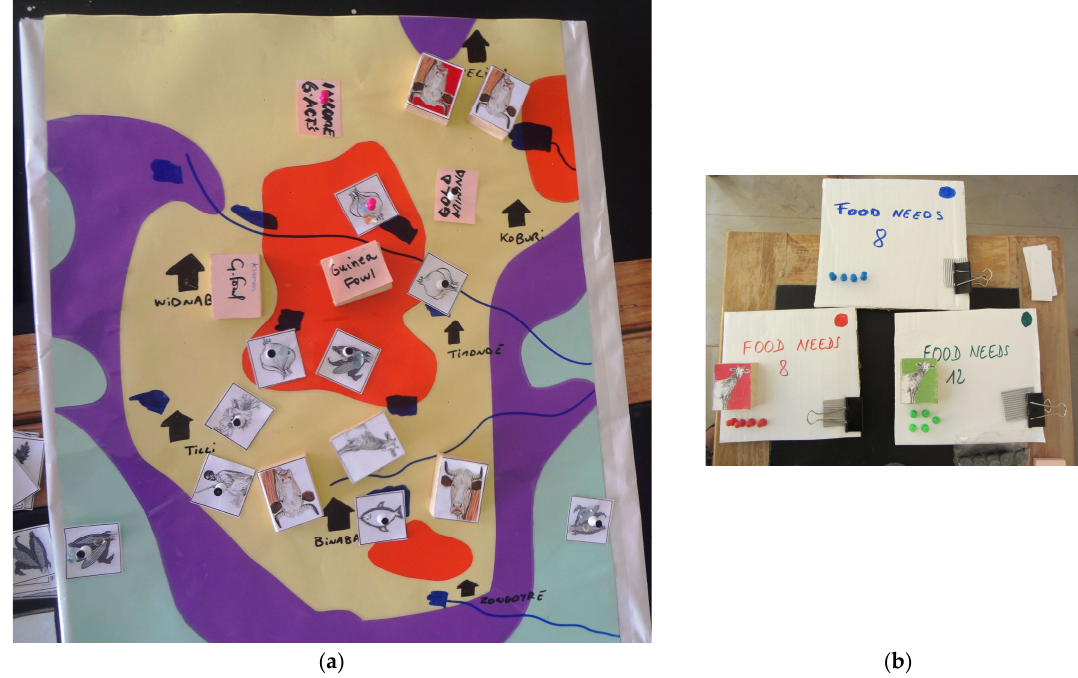
Figure 4. Bawkudo role-playing game ( a ) inclined wooden panel indicating landmarks and four types of land cover (in green, the forest area; in purple, rangeland; in yellow, mixed vegetation; in orange, cropland), with stickers indicating agricultural activities identified by players; ( b ) three players’ pads indicating an objective of food production to be reached by the household through a specific number of agricultural activities (represented by colored pins).